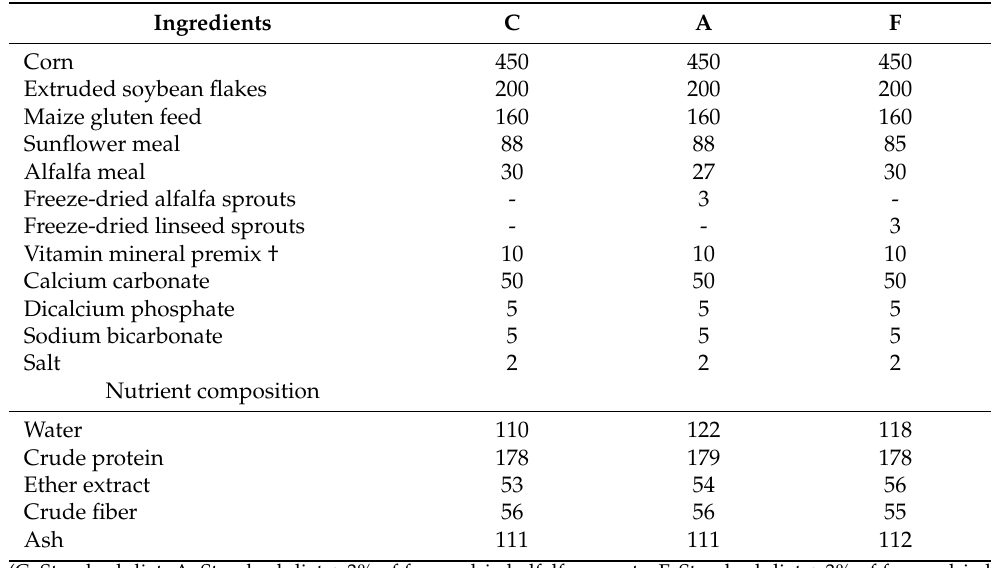
Table 1. Mean ingredients (g/kg) and nutrient composition (g/kg) of control and alfalfa or flax freeze-dried sprouts-enriched diets.